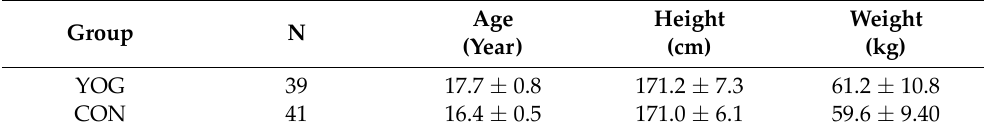
Table 1. Basic information of the participants (M ± SD).